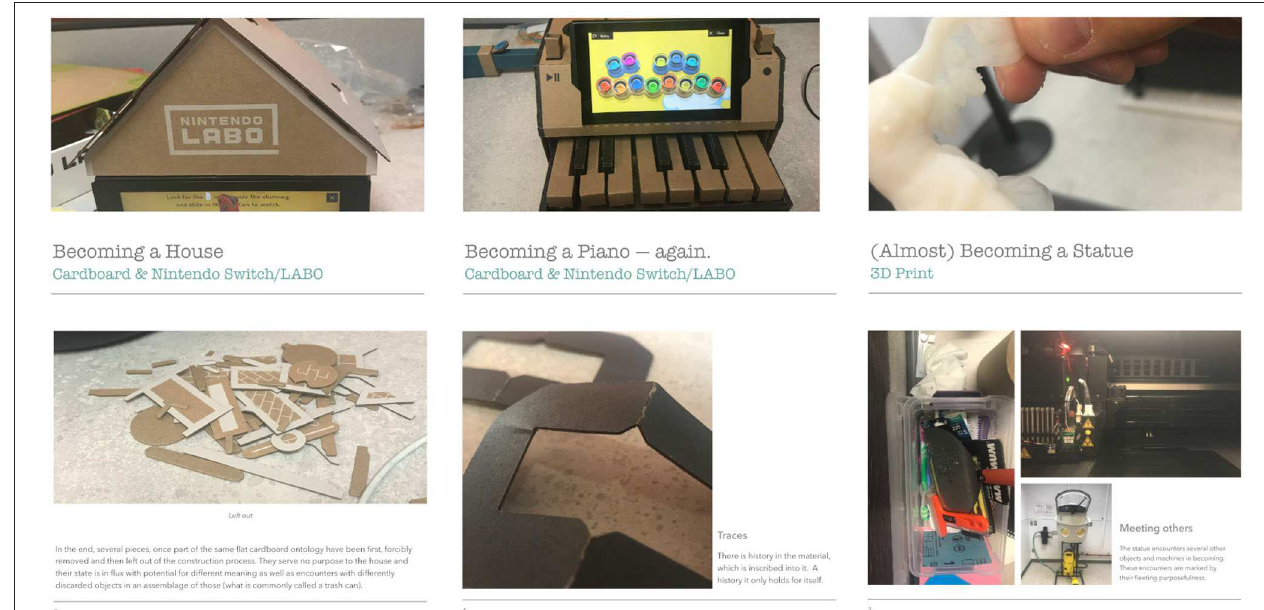
FIGURE 1 | Examples of booklets illustrating the becoming of the cardboard house and piano as well as the